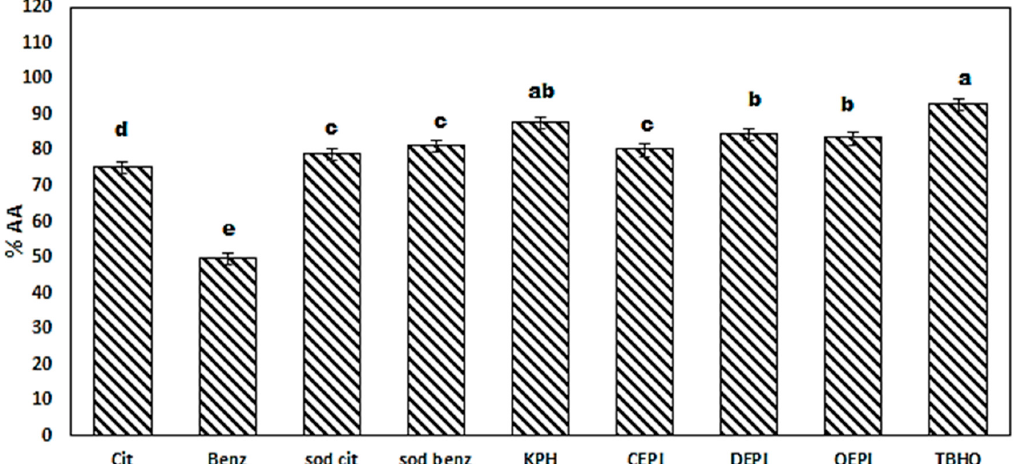
Figure 1. DPPH radical-scavenging activity of cucumber peel after 30 min compared with TBHQ. Mean with different letters above each column are significantly different ( p ≤ 0.05)